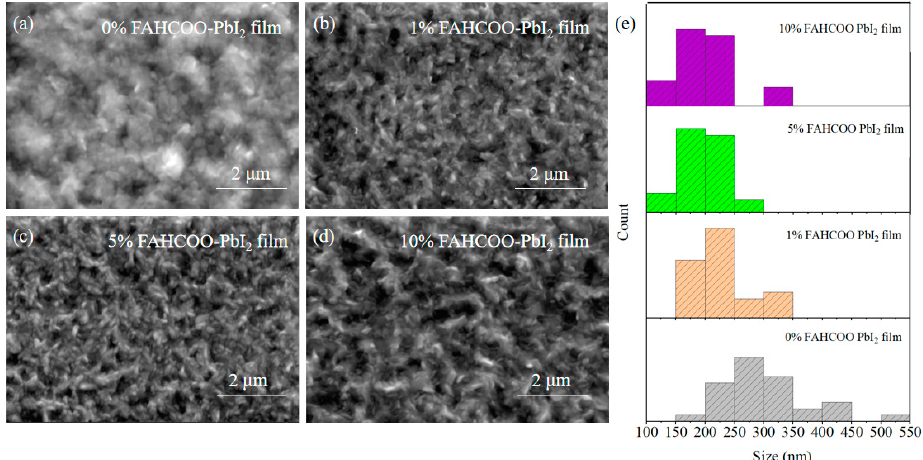
Figure 2. SEM comparison image of PbI 2 films prepared with different amounts of FAHCOO. ( a ) 0% FAHCOO PbI 2 film. ( b ) 1% FAHCOO PbI 2 film. ( c ) 5% FAHCOO PbI 2 film. ( d ) 10% FAHCOO PbI 2 film. ( e ) Diameters statistical diagrams of grains of PbI 2 films.